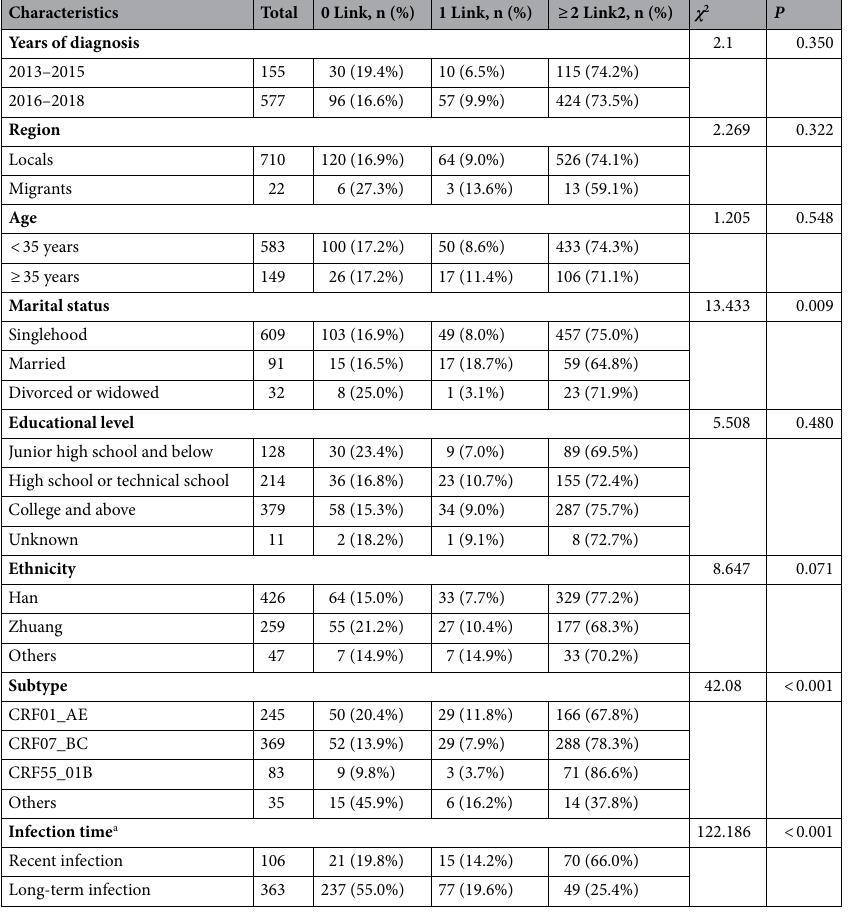
Table 1. Factors associated with potential transmission links (N = 732). a Only 469 newly diagnosed MSM in Guangxi from 2016 to 2018 were tested with the LAg-Avidity EIA to classify recent HIV-1